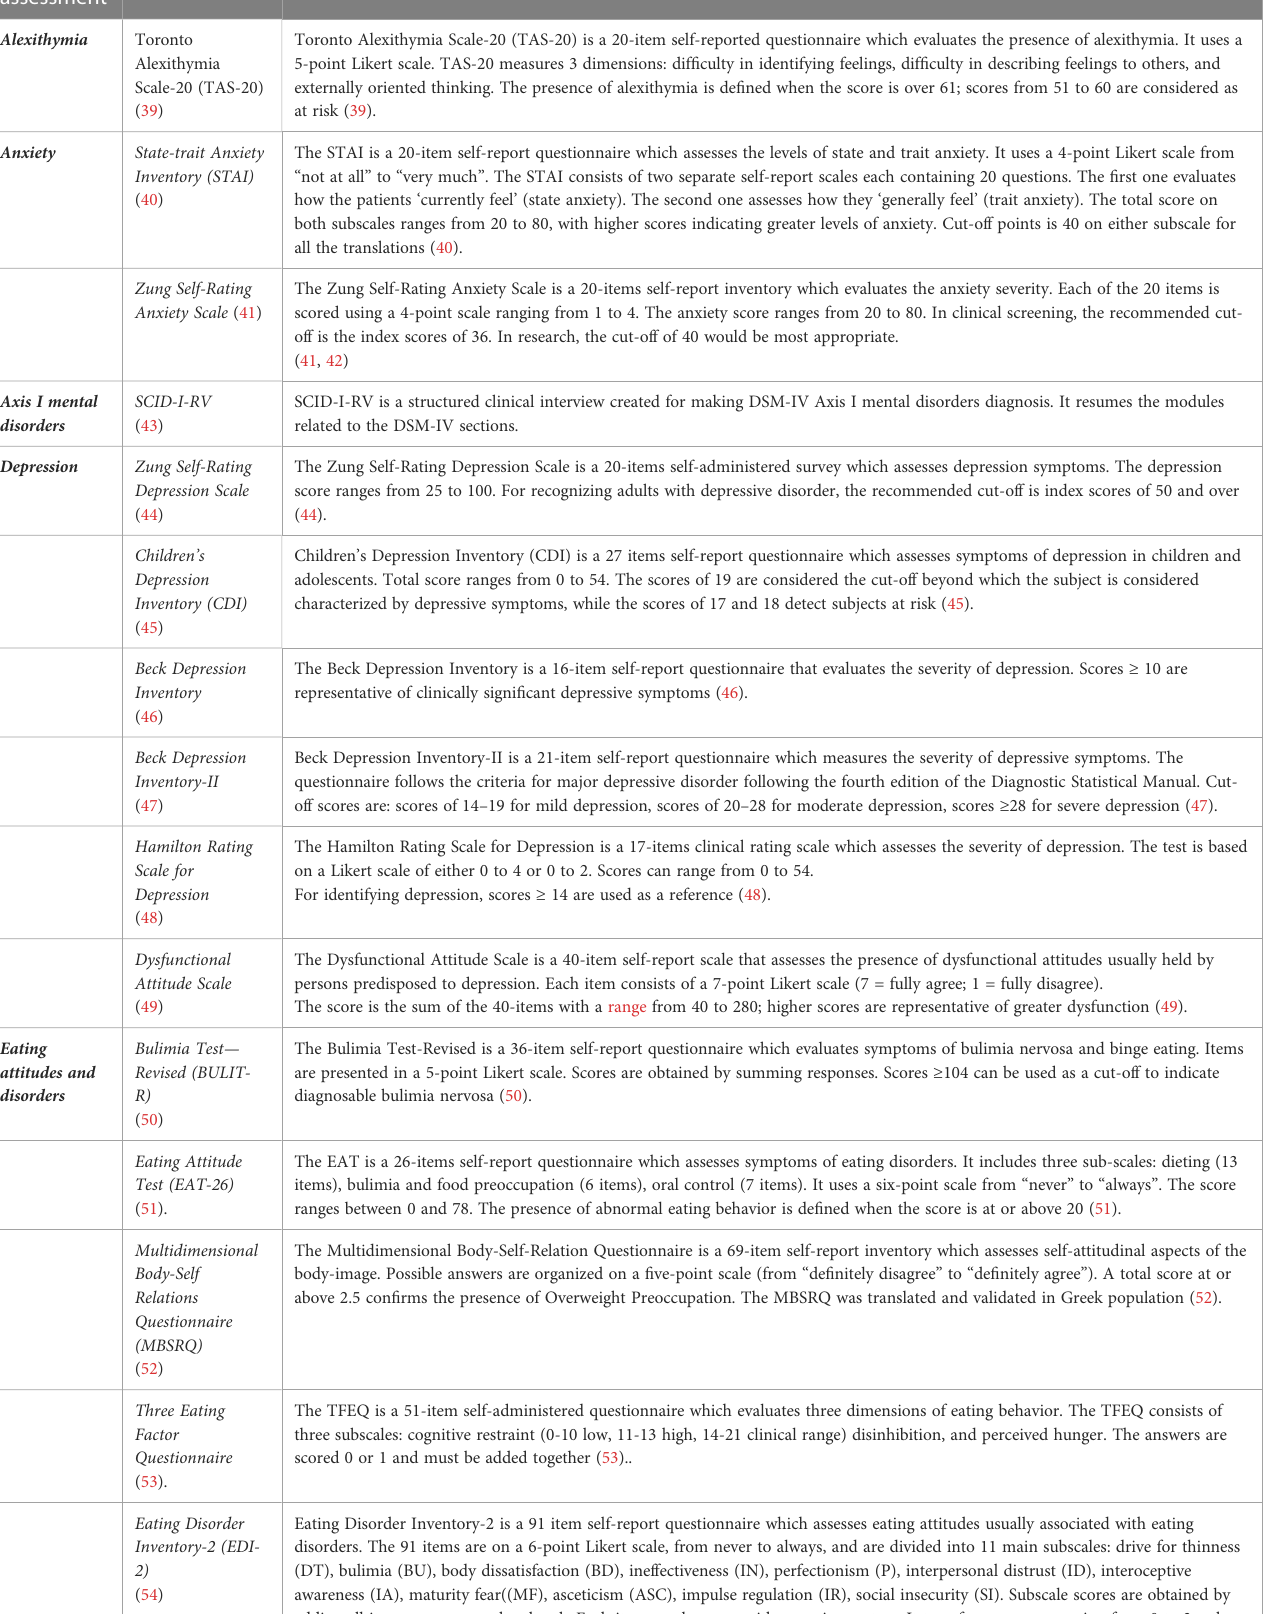
TABLE 2 Psychological assessment. Topics of